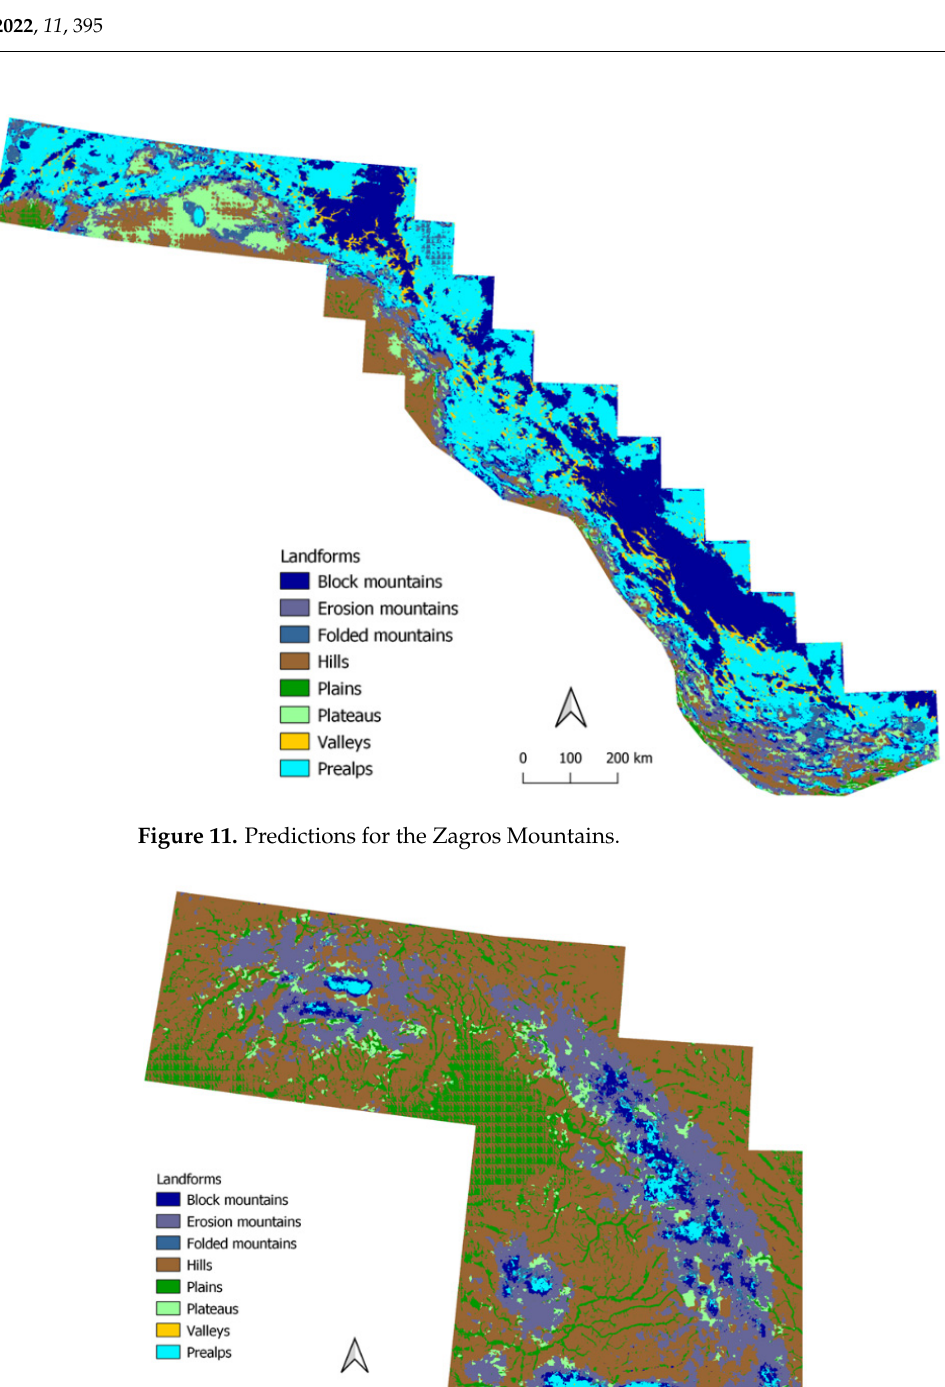
Figure 12. Predictions for the Carpathian Mountains